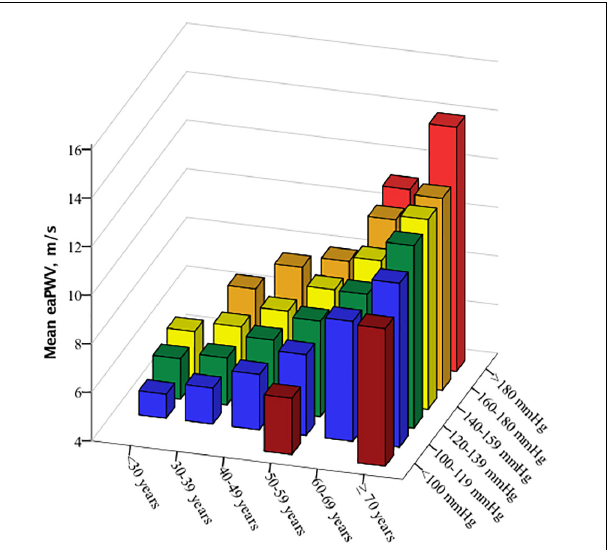
FIGURE 2 | Mean estimated aortic pulse wave velocity (eaPWV) values according to age and blood pressure categories.